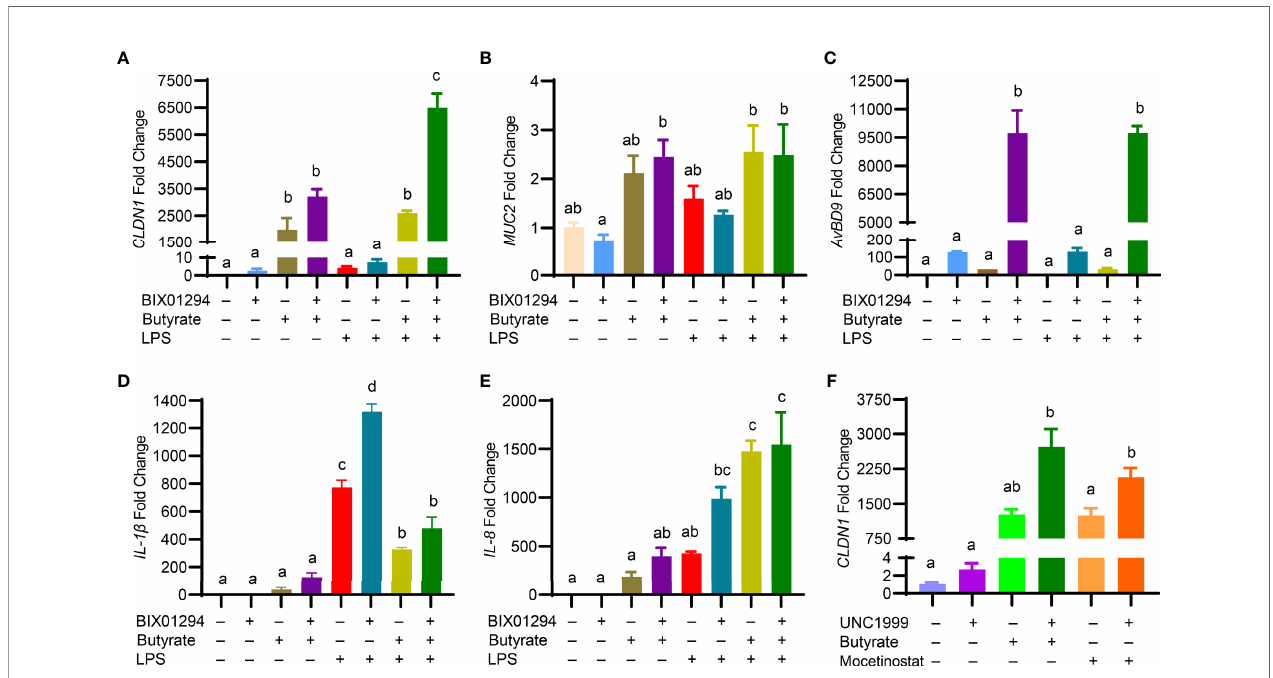
FIGURE 8 | Regulation of the genes involved in barrier function, host defense, and in fl ammation in HTC cells by HMTi and HDACi. Chicken HTC cells were stimulated in duplicate with 5 m M BIX01294 and 2 mM butyrate individually or in combination for 24 h, followed by 3-h stimulation with 10 ng/ml lipopolysaccharide (LPS) for another 3 h. RT-qPCR was performed to analyzed the expressions of CLND1 (A) , MUC2 (B) , AvBD9 (C) , IL-1 b (D) , and IL-8 (E) . (F) Chicken HTC cells were stimulated in duplicate with 5 m M UNC1999 or in combination with 2 mM butyrate or 2.5 m M mocetinostat for 24 h, followed by RT-qPCR analysis of CLND1 expression. Results are shown as means ± SEM of three independent experiments. The bars not sharing a common superscript are considered signi fi cantly different ( P < 0.05) based on one-way analysis of variance and post hoc Tukey ’ s